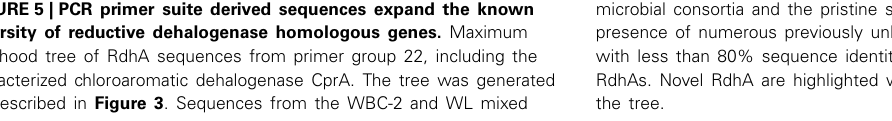
FIGURE 5 | PCR primer suite derived sequences expand the known diversity of reductive dehalogenase homologous genes. Maximum likelihood tree of RdhA sequences from primer group 22, including the characterized chloroaromatic dehalogenase CprA. The tree was generated as described in Figure 3 . Sequences from the WBC-2 and WL mixed